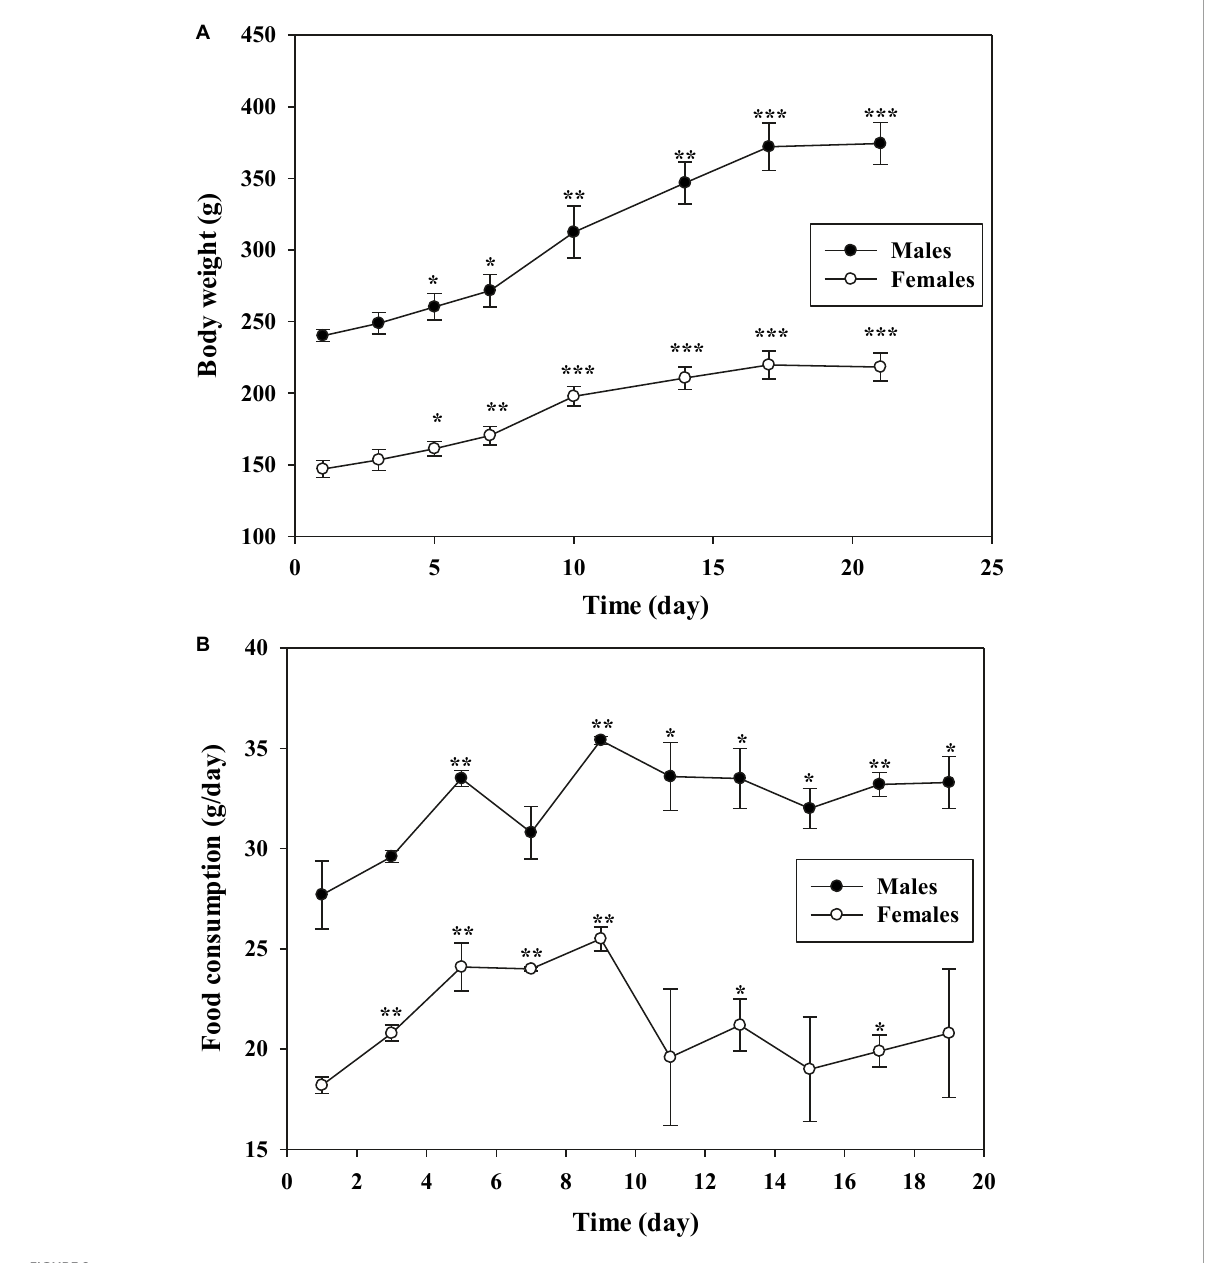
FIGURE2 The effects of AECPL on the body weights (A) and food consumption (B) of Sprague-Dawley (SD) rats during the sighting study. “*, **, and ***” refers to a significant difference from the 1st day at p ≤ 0.05, 0.01, and 0.001, respectively.